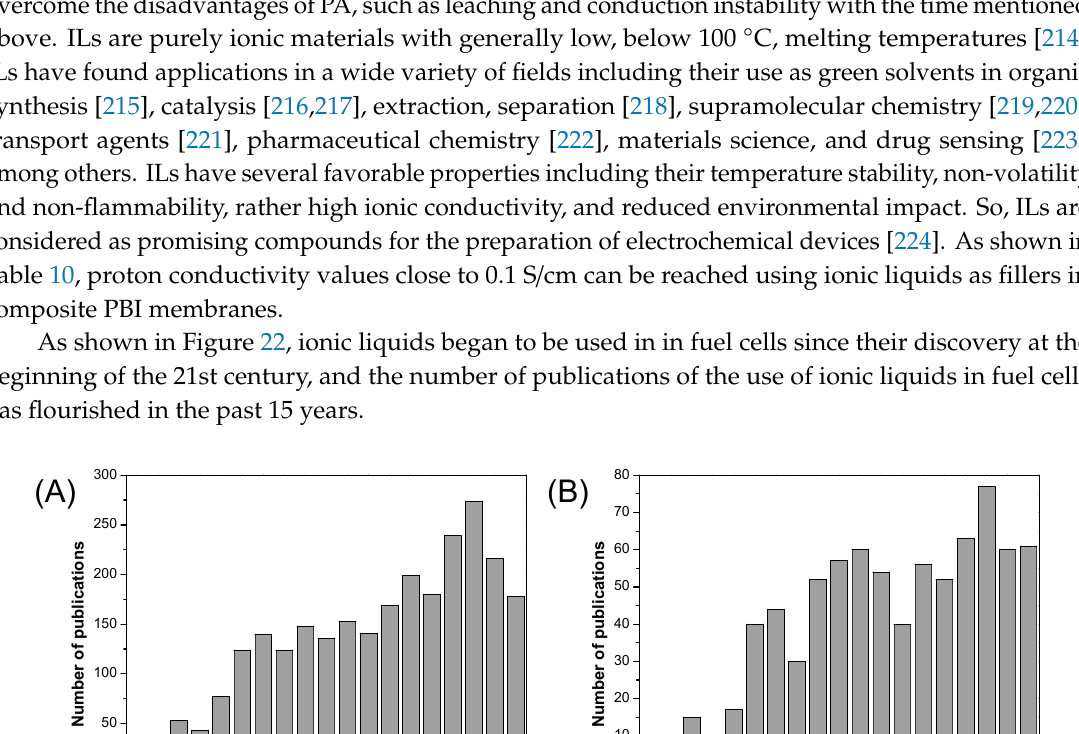
Figure 21. ( A ) Schematic representation of chemical structure of ZIF-8 and ZIF-69. ( B ) Structural representation of ZIF-8. (C) Field-emission scanning electron microscopy (FE-SEM) images of ZIF-8, ZI-67, and ZIF-mix. (D) Arrhenius plot of phosphoric acid doped PBI composite membranes containing 5 wt.% of ZIFs [77].